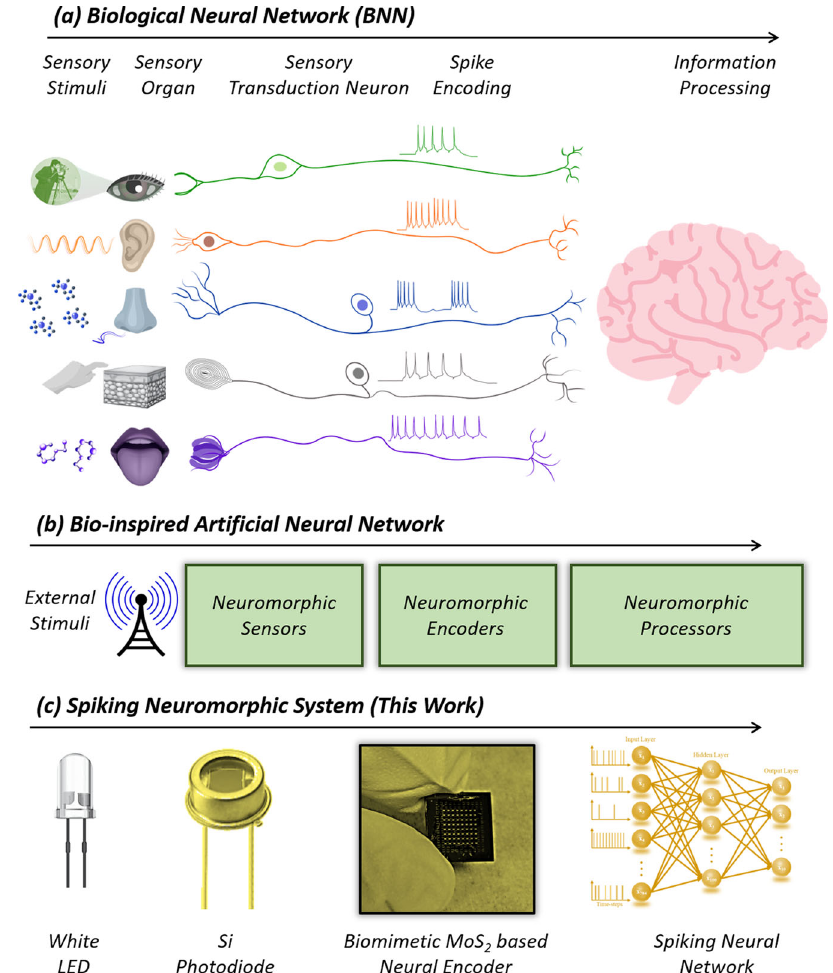
Fig. 1 Biomimetic neuromorphic computing. a Schematic of biological neural network (BNN). Specialized neurons convert analog external/internal stimuli into corresponding spike trains by a process called sensory transduction and subsequent relay the information to the central nervous system for further processing. Various encoding algorithms are found in sensory neurobiology such as spike rate-based, spike count-based, and spike timing-based encoding. b Schematic of bio-inspired arti fi cial neural network comprising of neuromorphic sensors, neuromorphic encoders, and neuromorphic processors. c Schematic of our spiking neuromorphic system consisting of a white light emitting diode (LED) as the visual stimulus, a silicon (Si) photodiode (PD) as the sensor, a dual gated MoS 2 based fi eld effect transistors (FETs) with a stochastic terminal as the neuromorphic encoder, and a trained spiking neural network (SNN) as the neuromorphic